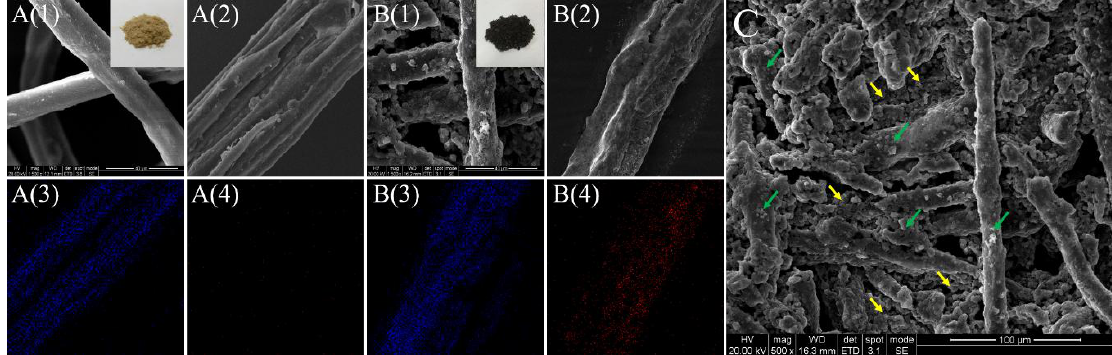
Figure 2. SEM and EDS images of the ( A ) untreated and ( B ) treated wood fibers. (3), (4) are EDS mappings of O and Fe for the separate wood fibers in A (2) and B (2), respectively. Insert: macro-structures of two samples. ( C ) is the SEM image of treated wood fibers in a large view. The typical particles and clusters in the spaces among the fibers and on the fiber surface are pointed to with yellow and green arrows, respectively. Table 1. The mass ratio of Fe element in the magnetic wood fiber obtained in different impregnation time.